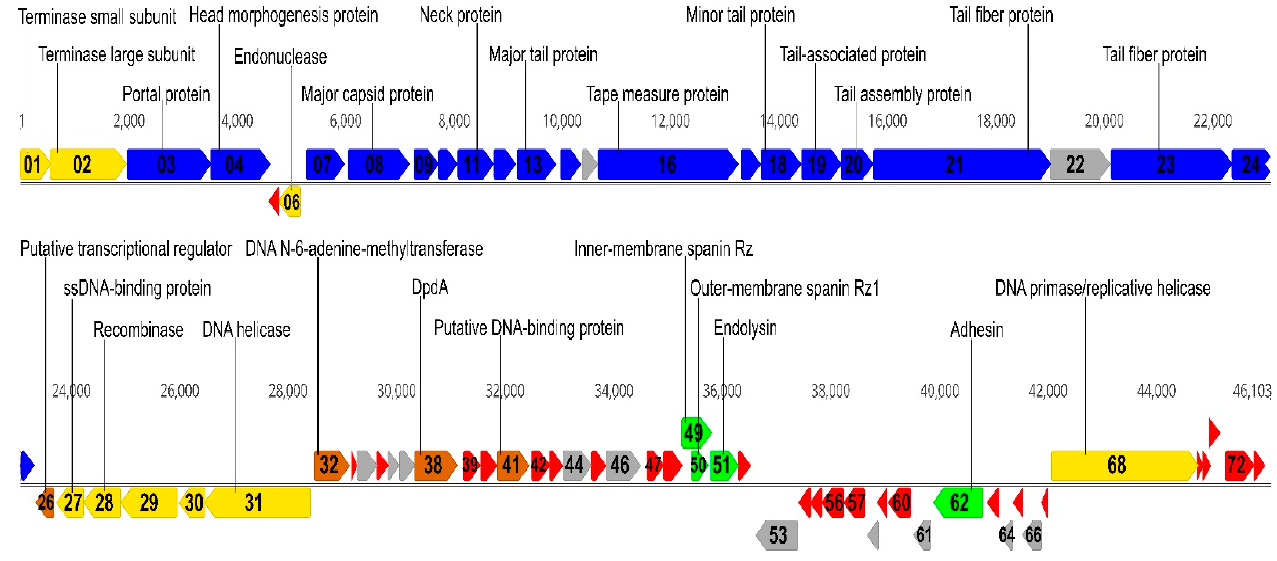
Figure 2. Functional genome map of bacteriophage MED16. The coding capacity of the genome is shown. Numbers indicate ORF position in genome; functions are assigned according to the characterized ORFs in NCBI database and HHpred analysis. The color code is as follows: yellow—DNA replication, recombination, repair and packaging; blue—structural proteins; brown—transcription, translation, nucleotide metabolism; green—lysis, phage–host interaction; grey—conserved hypothetical proteins; red—MED16 hypothetical proteins with no reliable identity when compared to database entries.